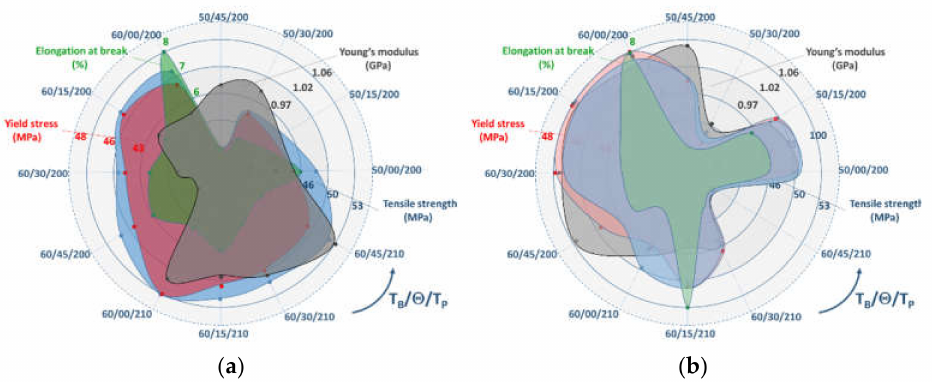
Figure 11. Parametric chart showing the dependence of the tensile properties on printing conditions for: ( a ) PLA; ( b )